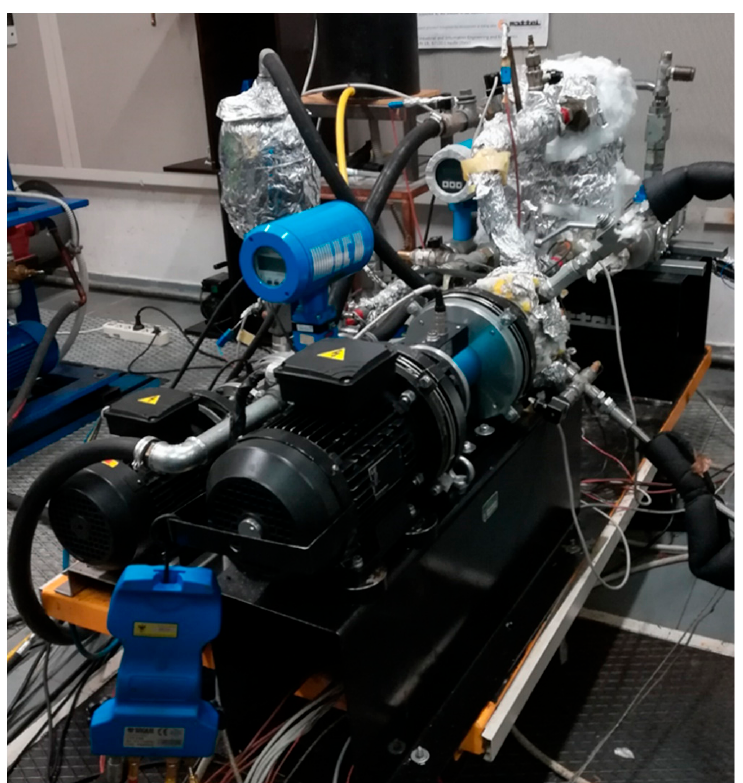
Figure 2. Organic Rankine cycle (ORC) plant experimental test bench.